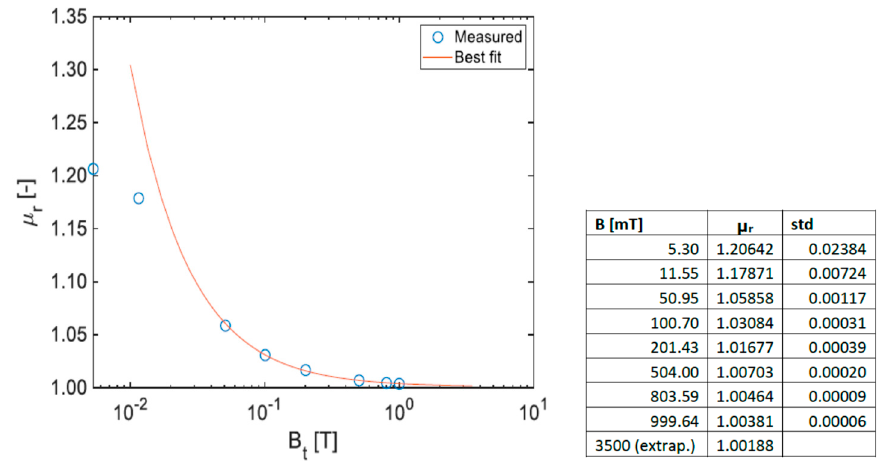
Figure 13. Magnetic permeability of the coated PM specimen as a function of the test field. Measurements at respectively 5 mT, 10 mT, 50 mT (using a Hall teslameter), 100 mT, 200 mT, 500 mT and 1 T (NMR teslameter) were performed. The saturation field of pure Ni is of the order of 0.64 T; however, since the permeability at the different fields is measured as secant from the origin, a continuous decrease is observed even above this field.